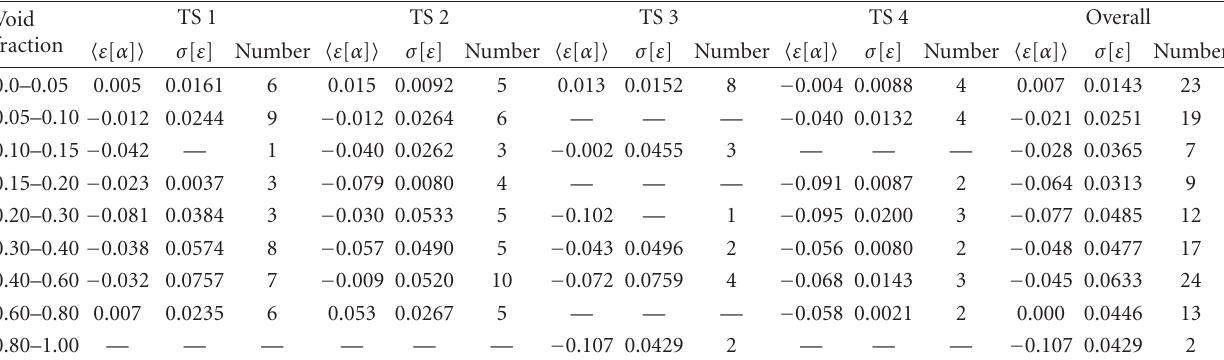
Table 2: Summary of subchannels results by CATHARE2